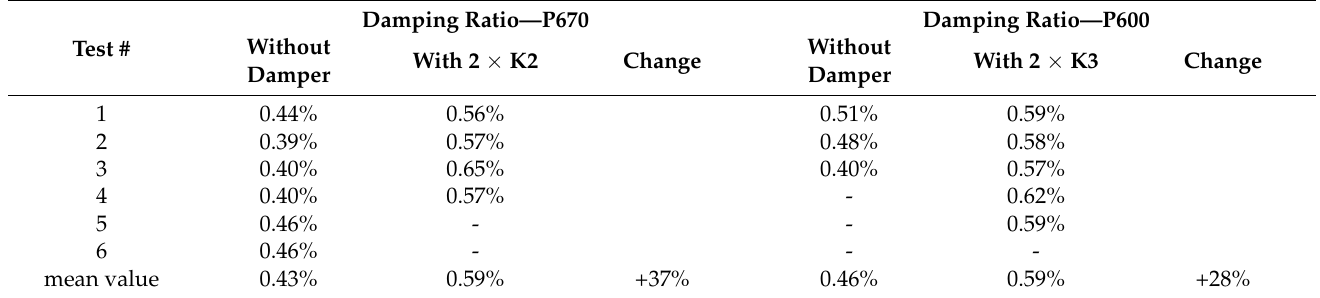
Table 5. Experiment results: damping ratio of the beams with/without the